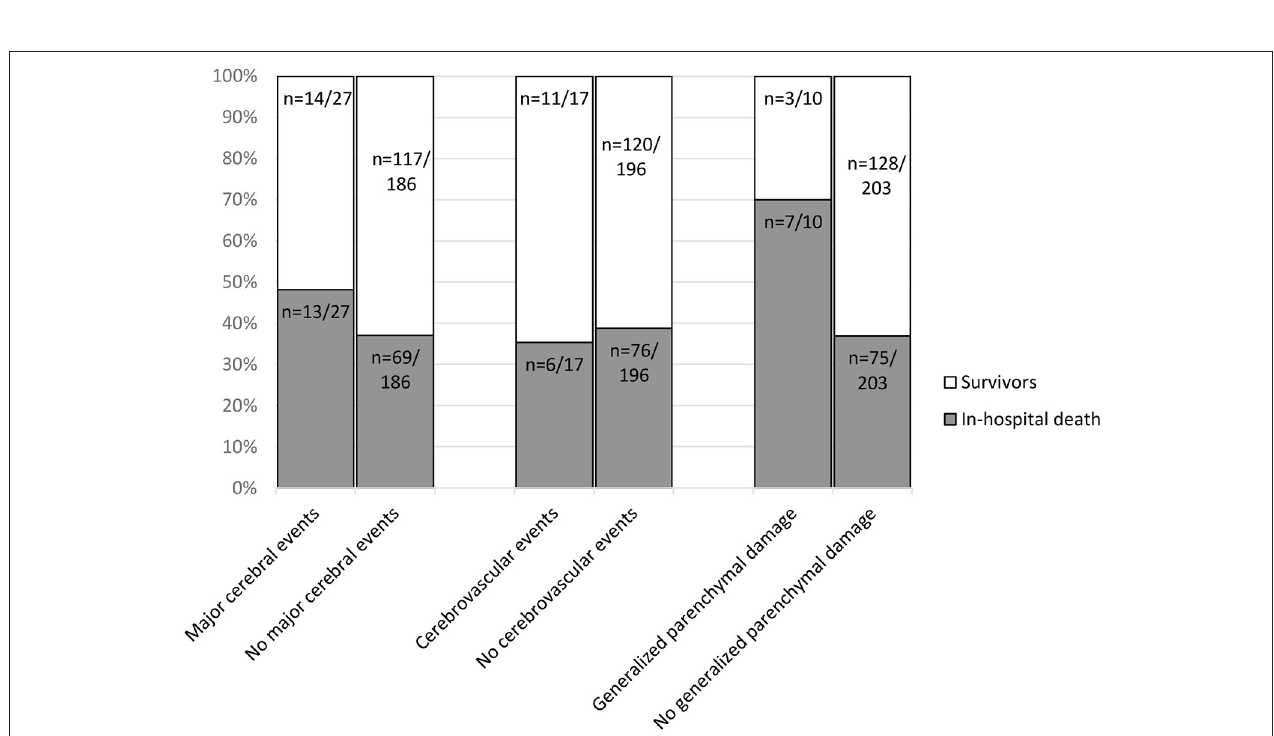
FIGURE 5 | In-hospital death associated with image findings in n = 213 patients in a total of 278 CT examinations. The number of cerebrovascular events per patient ( n = 17/213) differs from the previously mentioned number of cerebrovascular events in CT-scans in Table 2 ( n = 20/278). Reason being, that some patients received multiple CT-scans. For the calculation of in-hospital death every patient was only included once. Contingency tables were used to compare the outcome parameter in-hospital death for patients with and without specific imaging findings. No statistically significant association was found with major cerebral events ( p = 0.27). Also, cerebrovascular events were not significantly associated with mortality ( p = 0.77). A significant association was established between in-hospital death and generalized parenchymal damage ( p = 0.04) with an in-hospital mortality of 70 % ( n = 7/10) in patients with generalized parenchymal damage vs. 36.9% ( n = 75/203) in patients without generalized parenchymal